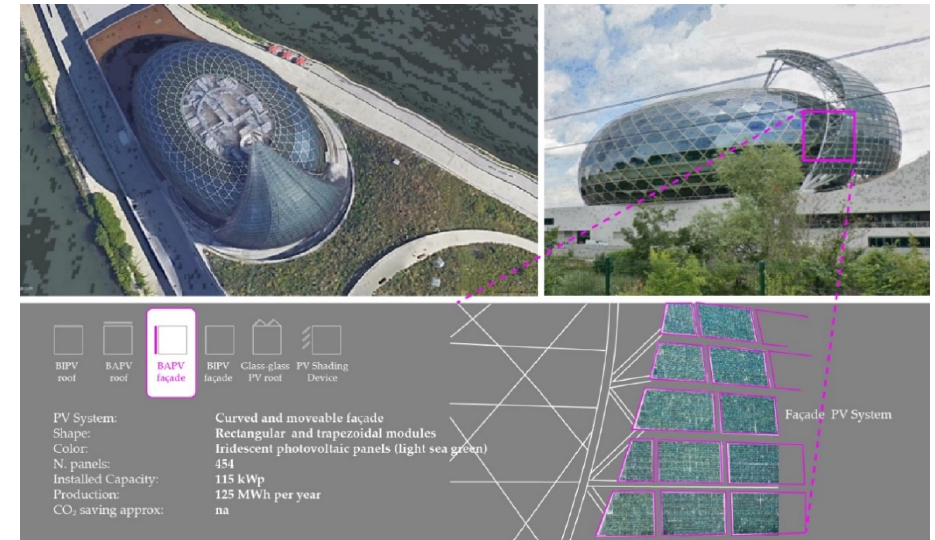
Figure 10. La Seine musicale (on top Source of illustrations Google Earth, Google 2020) ( on the top ); Integration and characteristics of PV systems ( on the bottom ).